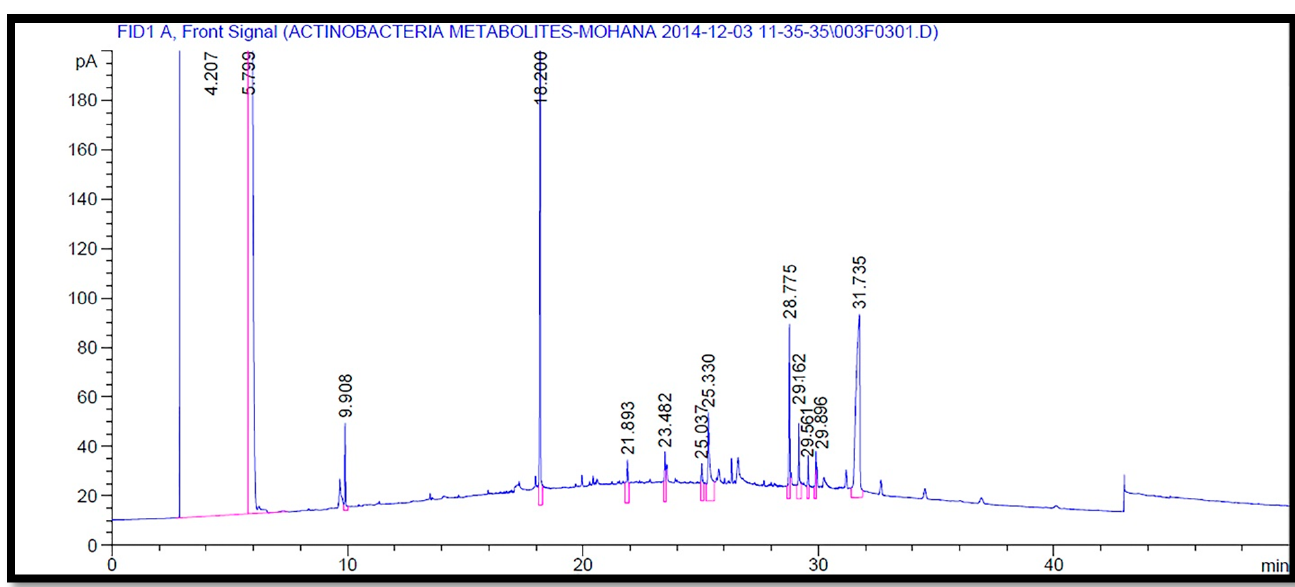
Figure 3. The GC-MS chromatograms analysis of volatile organic compounds of the ethanolic crude extract in fraction number 2 at different retention times. Table 3. Antimicrobial compounds identified in the ethyl acetate extract by GC-MS from fraction no. 7. Tables 2 and 3 represents the name of the compound, molecular formula, molecular weight, area, quality, and activity. In addition, Figure 4 illustrates the compounds and their chemical structures. Table 2. Antimicrobial compounds identified in the ethyl acetate extract by GC-MS from fraction no. 2. R. Peak no